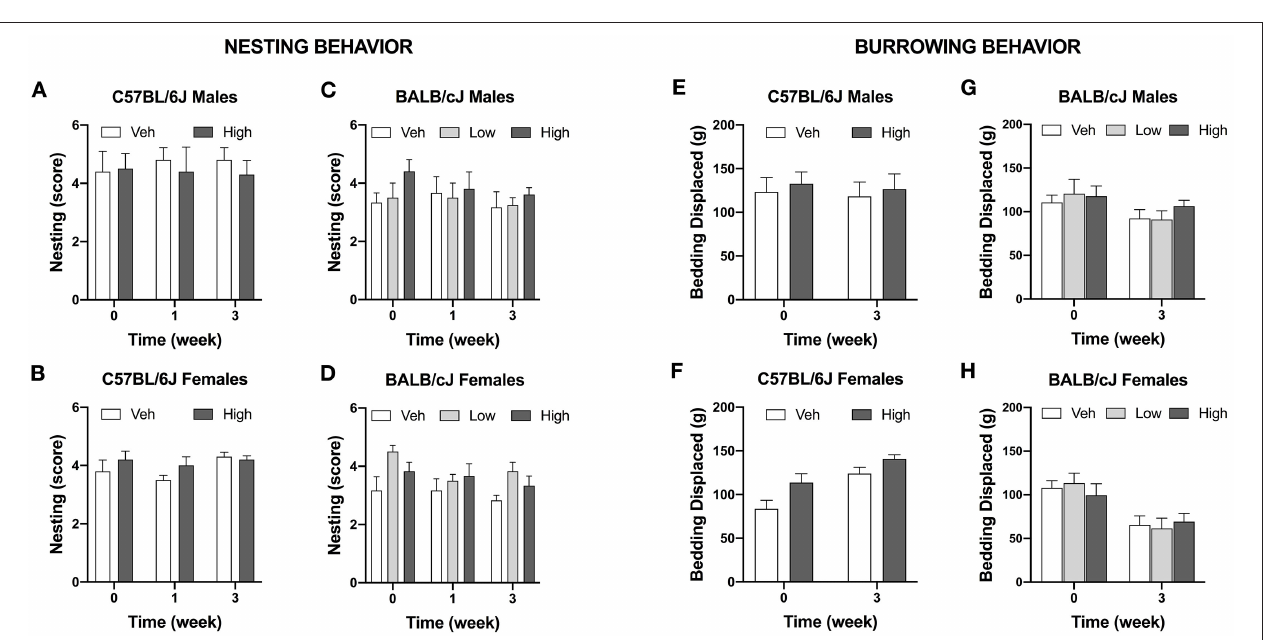
of the low-dose regimen treated mice showed changes in affective-like